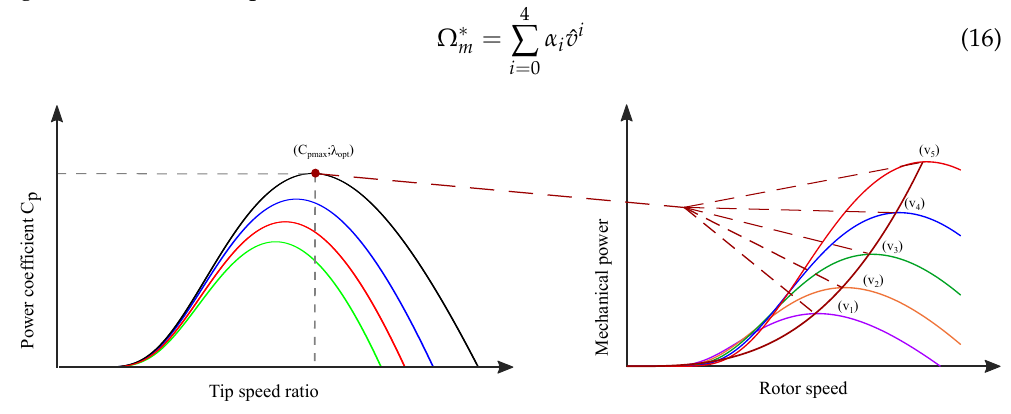
Figure 7. WT power